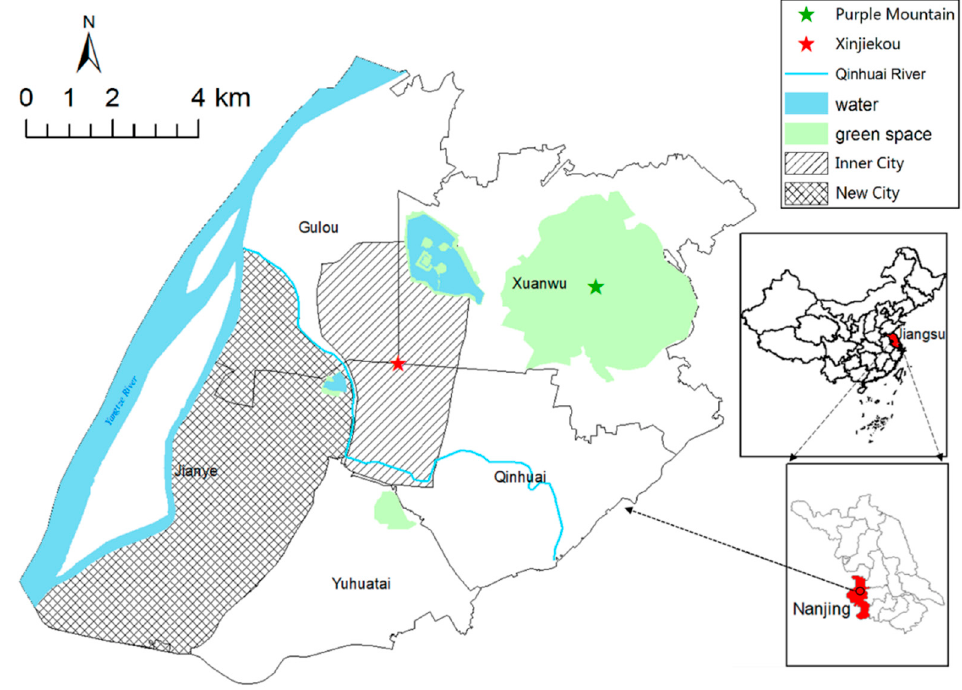
Figure 1. Location of the study area. The urban area of Nanjing consists of Gulou, Xuanwu, Jianye, Qinhuai, and the northeastern Yuhuatai district. Xinjiekou is the largest commercial area located in the city center. The inner city includes the area inside the inner ring road, also called the “old city” of Nanjing. The new city is a newly built district named “Hexi New City”.